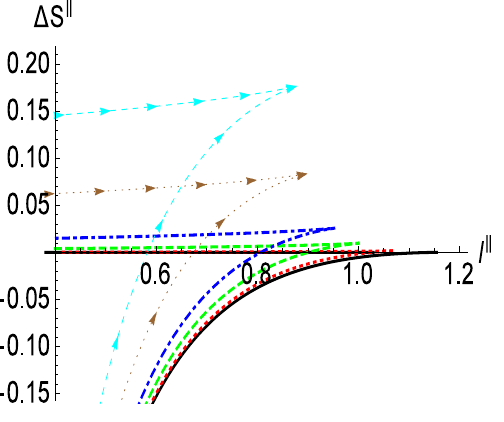
Figure 6 . (cid:1) S k as a function of ‘ k for var- ious B , with ‘ c = 1. Here c = 0 : 3 and (solid, black), (dot, red), (dash, green), (dot- dash, blue), (arrow-dot, brown) and (arrow- dash, cyan) curves correspond to B = 0, 0 : 1, 0 : 2, 0 : 3, 0 : 5 and 0 : 7 respectively. In units GeV.